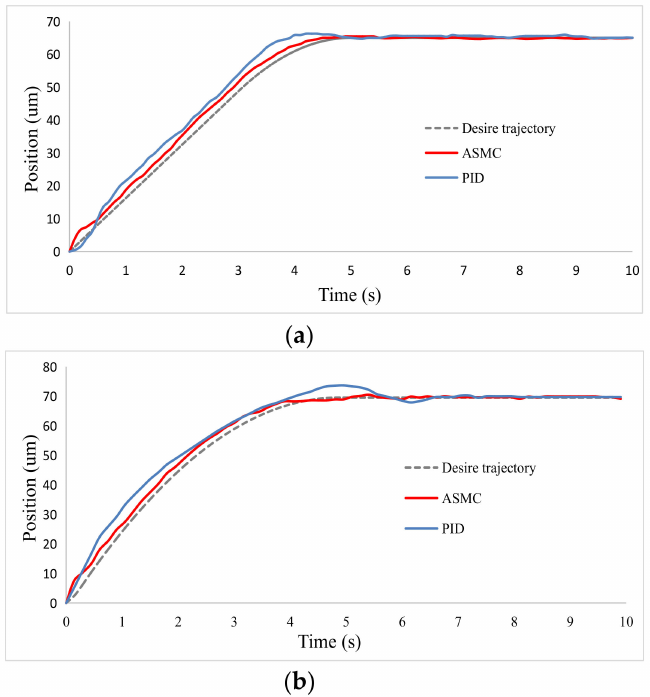
Figure 10. Cytoplasm extracting control result. ( a ) Quadratic trajectory tracking control result. ( b ) Ramp trajectory tracking control result.